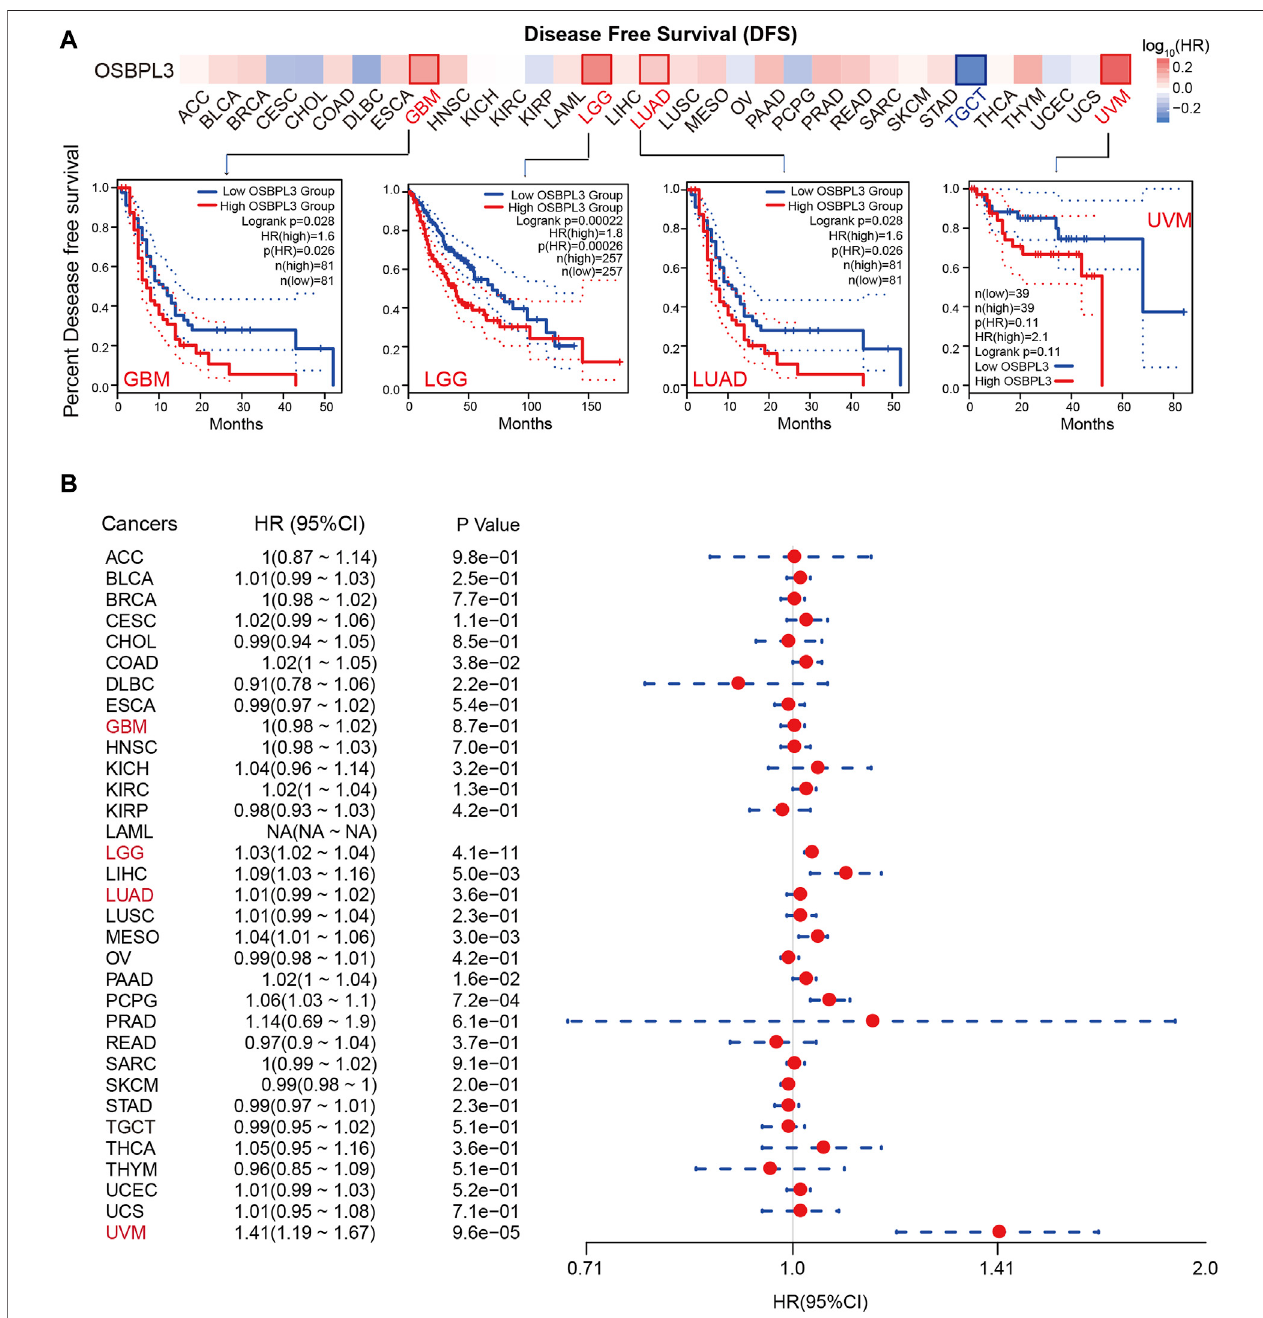
FIGURE4| CorrelationbetweenOSBPL3 expression anddisease-freesurvival(DFS)prognosisofdifferentcancers. (A ) Disease-free survivalanalyses ofOSBPL3 gene expression across different tumors in TCGA via the GEPIA2 dataset. Up: survival map; down: Kaplan – Meier plotter curves. (B) A meta-analysis (forest plot) for pooling of a series of univariate disease-free survival of OSBPL3 expression in different tumors. Hazard ratios (HRs), 95% con fi dence intervals (95% CIs), and p -values are shown.